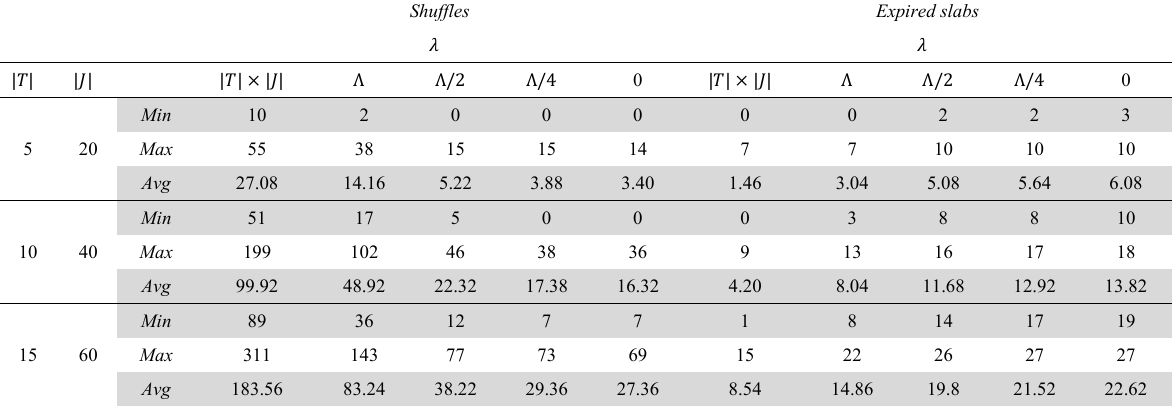
Results of Experiment 1: number of shuffles and expired slabs